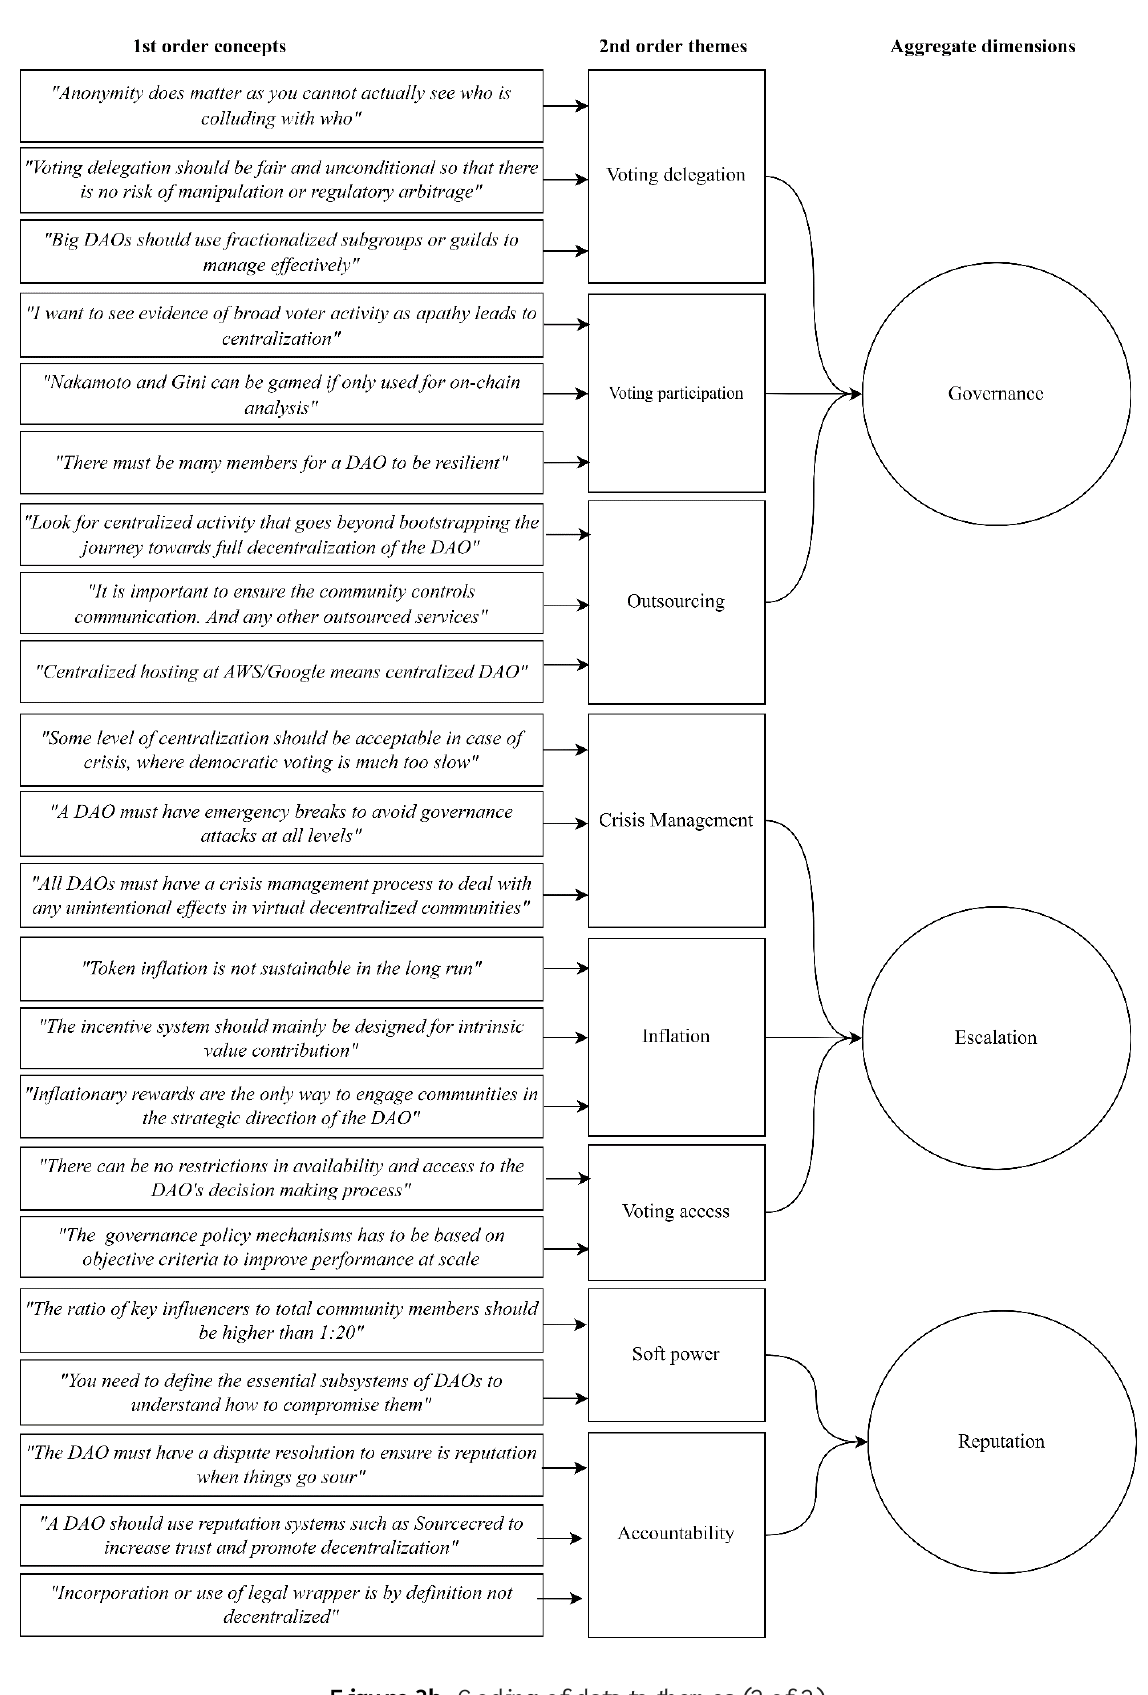
Figure 3b. Coding of data to themes (2 of